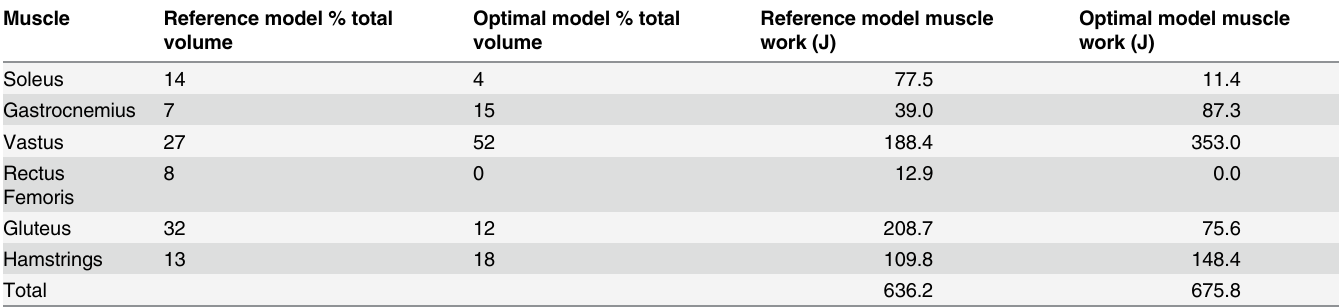
Table 1. Muscle volume and work for both the reference and optimized